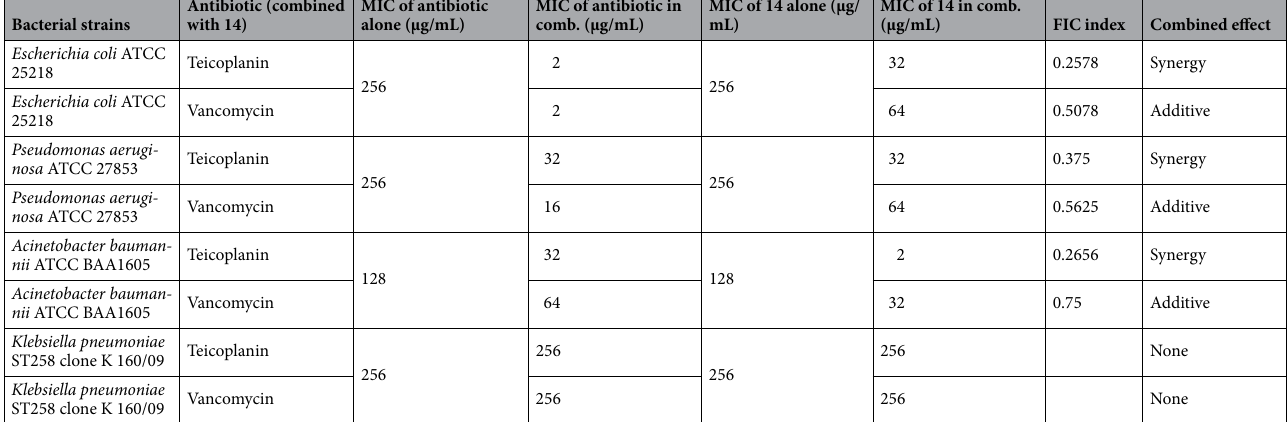
Table 4. Adjuvant potency of compound 14 in combination with teicoplanin and vancomycin.